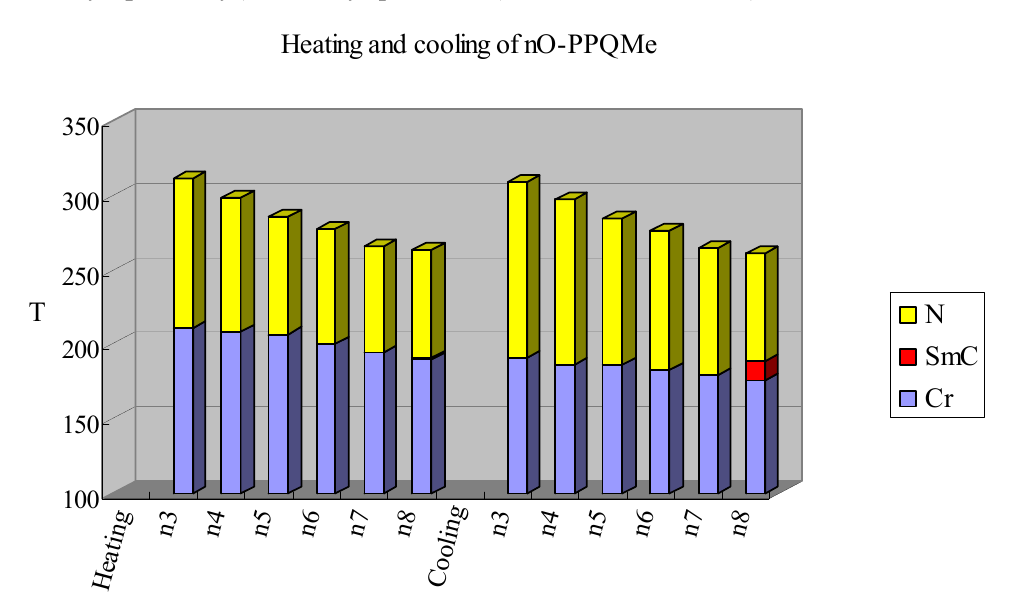
Figure 3. Plot of transition temperatures of heating and cooling cycle for compounds of 2-(4'-alkoxybiphen-4-yl)-6-methylquinoline ( n O-PPQMe, n =